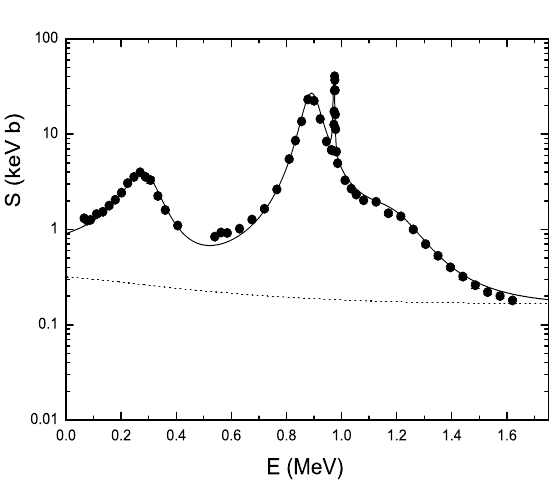
Figure 3. The astrophysical S factor for the 9 Be( p , γ ) 10 B reaction. The points are the experimental data from [17]. The solid and dashed lines are the results of the present work for the total and direct radiative capture,